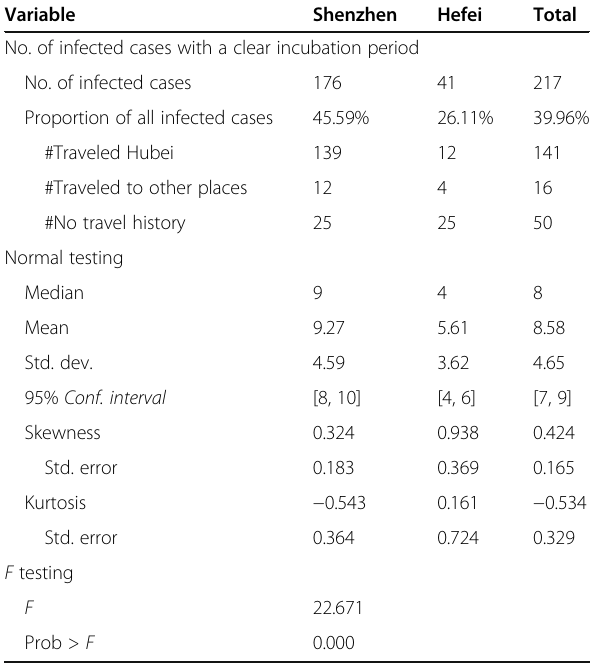
Table 4 ANOVA on the incubation period between infected cases in Shenzhen and Hefei